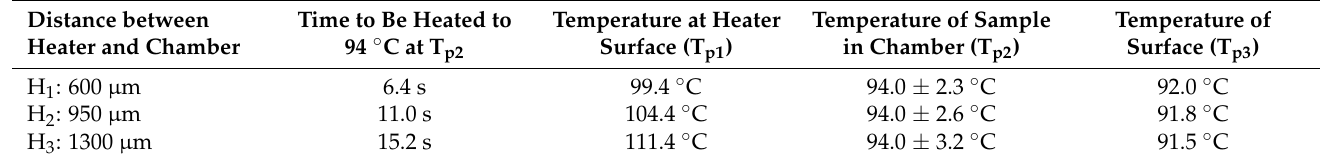
Table 2. Simulation result to time to reach sample temperature of 94 ◦ C for each condition.